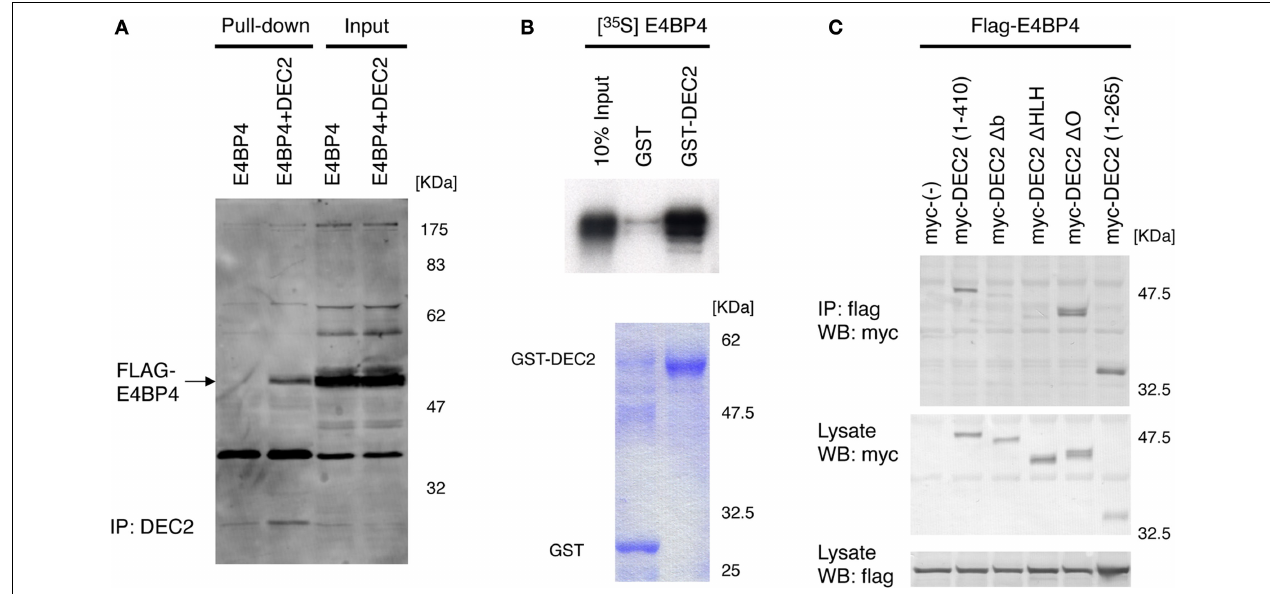
bottom panel shows the corresponding SDS-PAGE gel stained with Coomassie blue (B) . (C) bHLH domain of DEC2 plays a crucial role in binding of E4BP4. COS-7 cells were transfected with myc-tagged Dec2 expression vectors together with flag-tagged E4BP4 expression vector. Cell lysates were immunoprecipitated with anti-flag antibody and immunoblotted with anti-myc antibody. To confirm expression of E4BP4 and DEC2 proteins, aliquots of the total cell lysates were immunoblotted with the anti-flag and anti-myc antibodies. b, basic region; HLH, helix–loop–helix domain; O, orange domain. Numbers indicate the position of amino acids in the DEC2